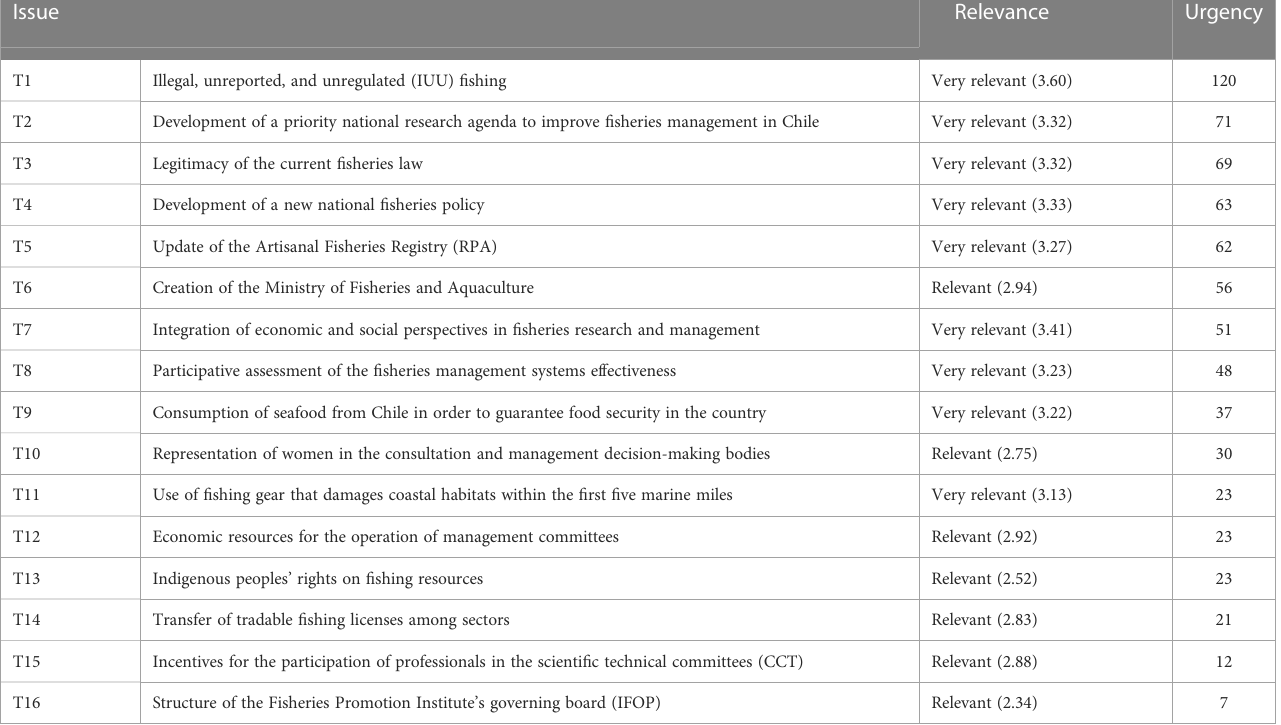
TABLE 2 Relevance and urgency score of the issues proposed in the